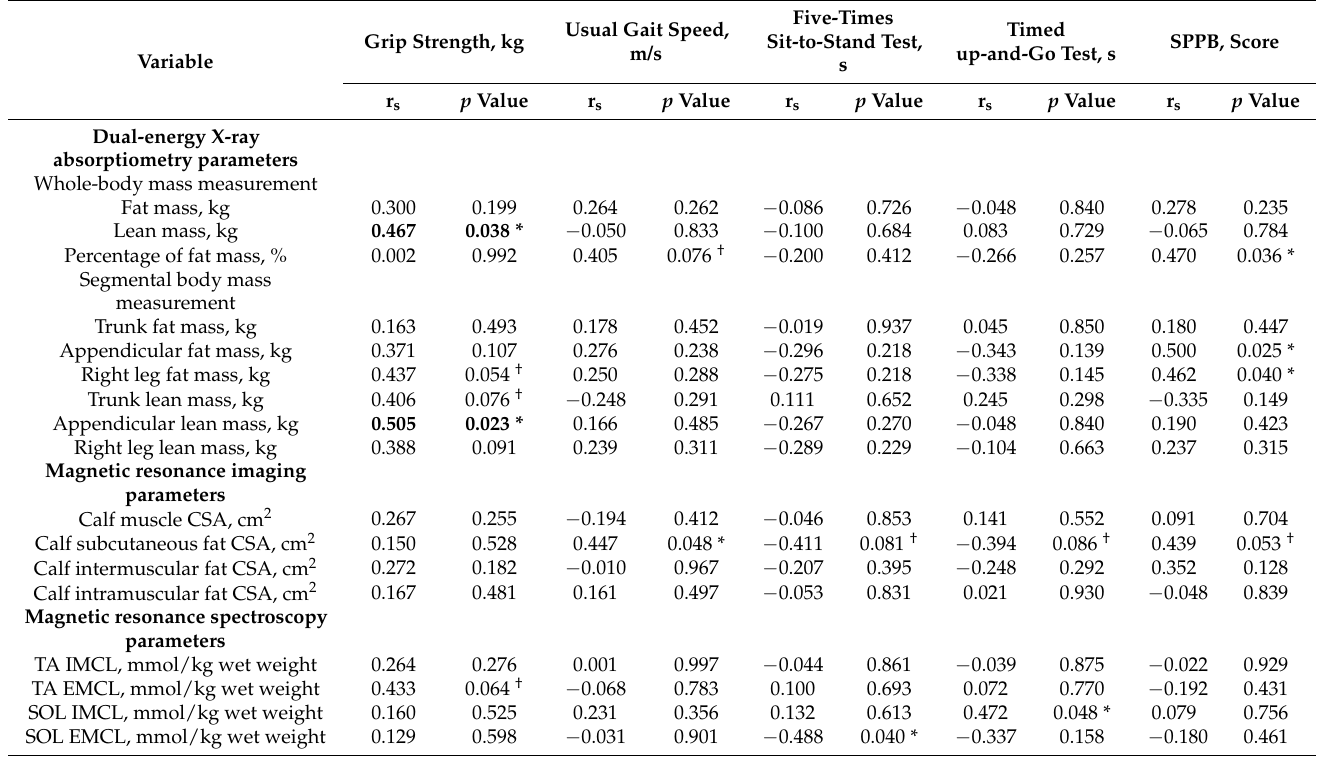
Table 3. Relationship between physical performance and body composition measures in